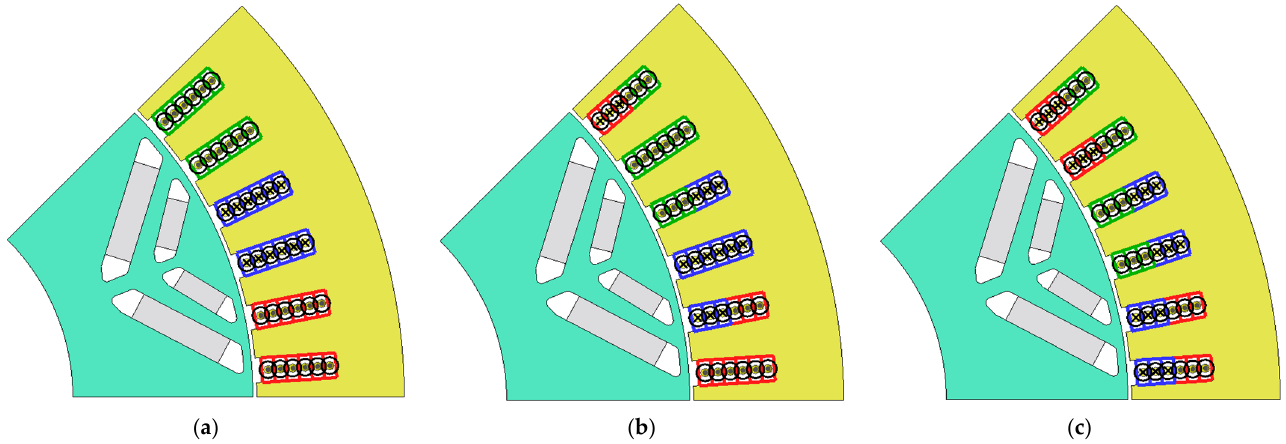
Figure 9. Three winding layout configurations: ( a ) FP winding layout with single-phase conductors in each slot; ( b ) SP-A winding layout with single-phase and two-phase conductors in each slot; ( c ) SP-B winding layout with only two-phase conductors in each slot.